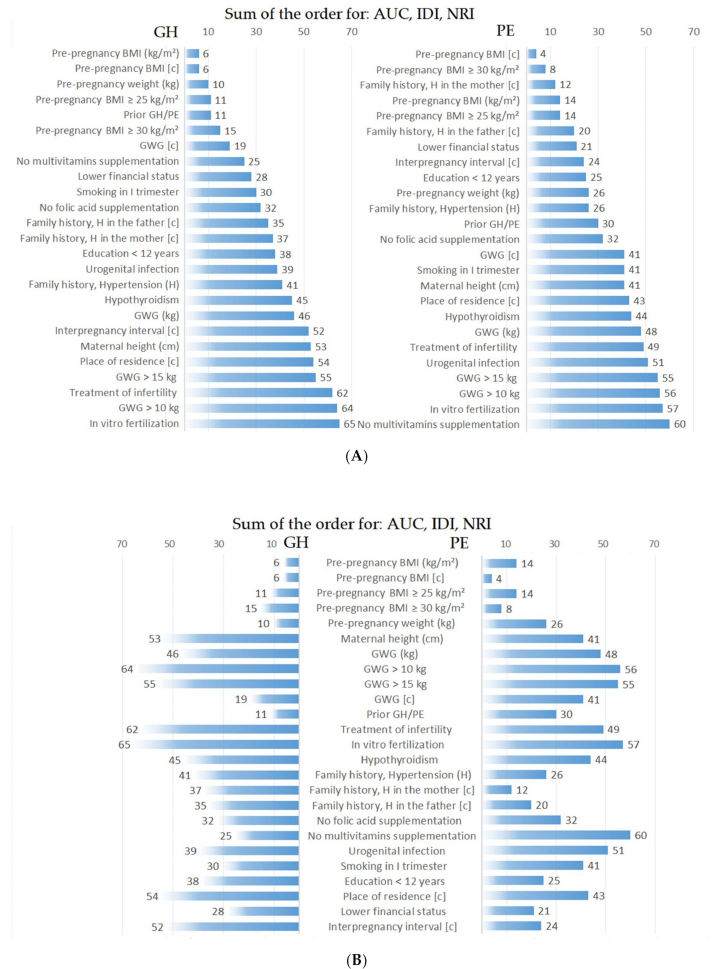
Figure 1. A new order of significance of the maternal factors after the sum of the sequences obtained from the three measures (AUC, IDI and NRI). The image at the top ( A ) highlights those maternal traits that improved predicting the most. The image at the bottom ( B ) shows the variables and their groups and highlights the di ff erences between GH and PE for each variable. BMI, body mass index; (c), categories as described for independent variables in the Methodology; GWG, gestational weight gain; H, hypertension in family history; AUC, area under receiver operating characteristic curve; IDI, Integrated Discrimination Improvement; NRI, Net Reclassification Improvement; GH, gestational hypertension; PE,